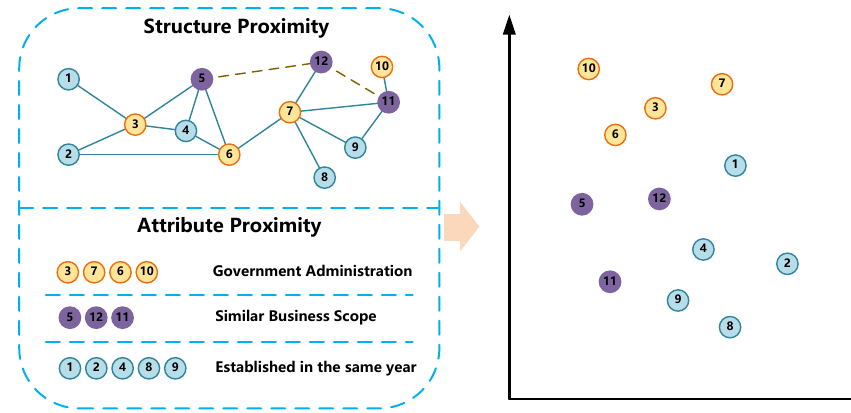
Figure 13. Attributed social network